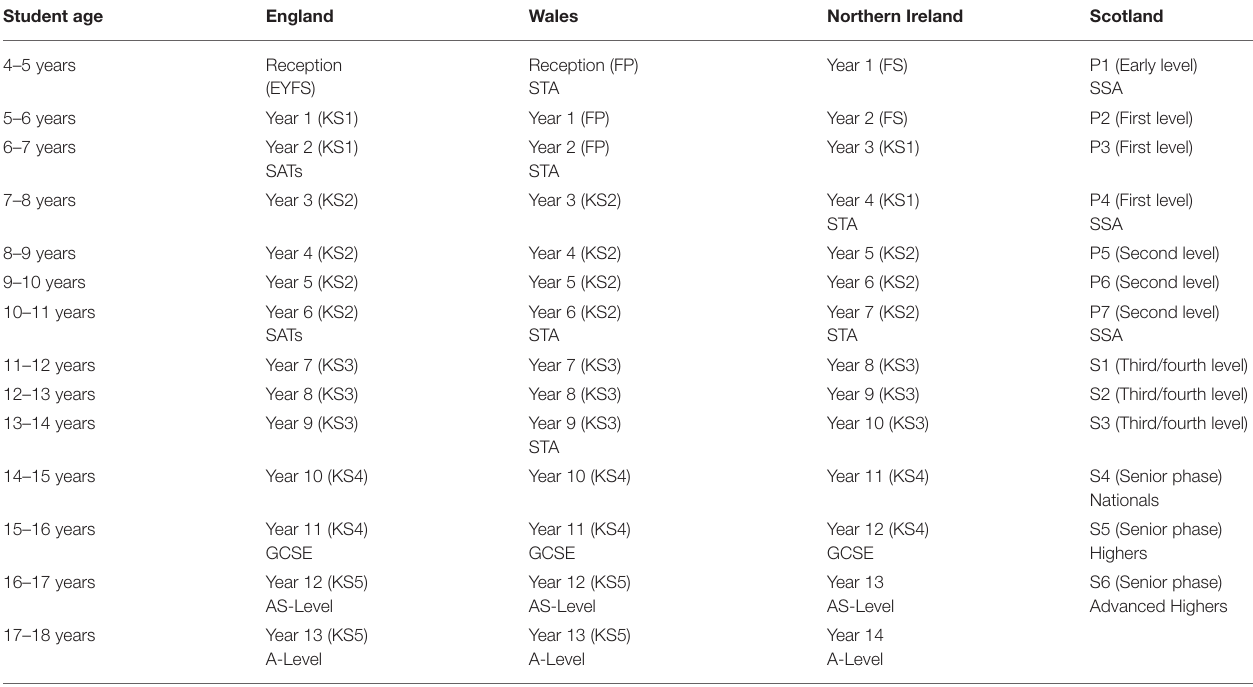
TABLE 1 | Structure of education systems in the UK (approximate equivalents) a . Student